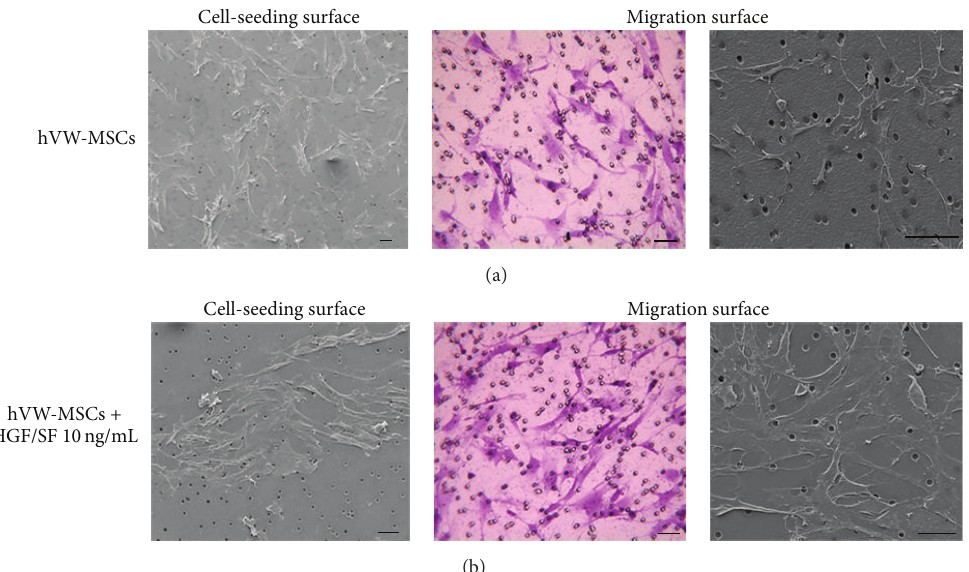
Figure 4: Motility effect of HGF/SF on hVW-MSCs. Representative Crystal Violet and SEM images of (a) untreated (hVW-MSCs) and (b) HGF/SF- (10ng/mL) treated hVW-MSCs migrated through an 8 𝜇 m porous membrane adhering to the migration surface. The cell-seeding surface analysis showed that the chemotactic HGF/SF facilitated the migration of many hVW-MSCs. Histological and SEM images: scale bars = 50 𝜇